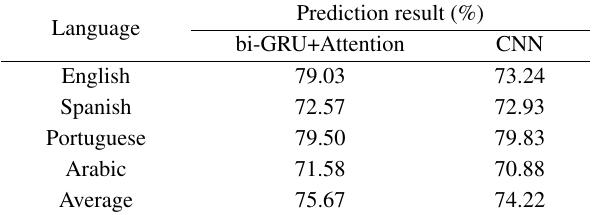
Table 14 Prediction results obtained for